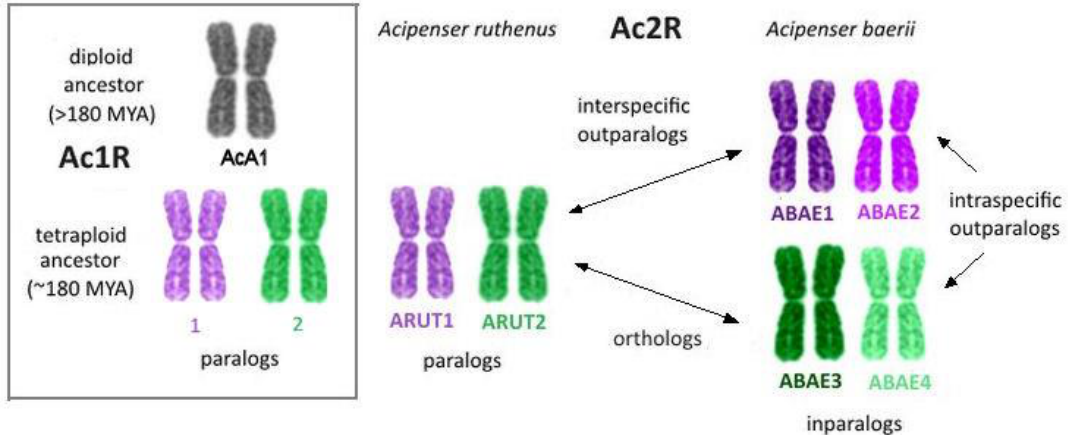
Figure 1. Di ff erent types of chromosome homology relations in polyploid acipenserids, which genomes Figure 1. Different types of chromosome homology relations in polyploid acipenserids, which underwent either one (Ac1R), or two (Ac2R) whole-genome duplication genomes underwent either one (Ac1R), or two (Ac2R) whole-genome duplication events.